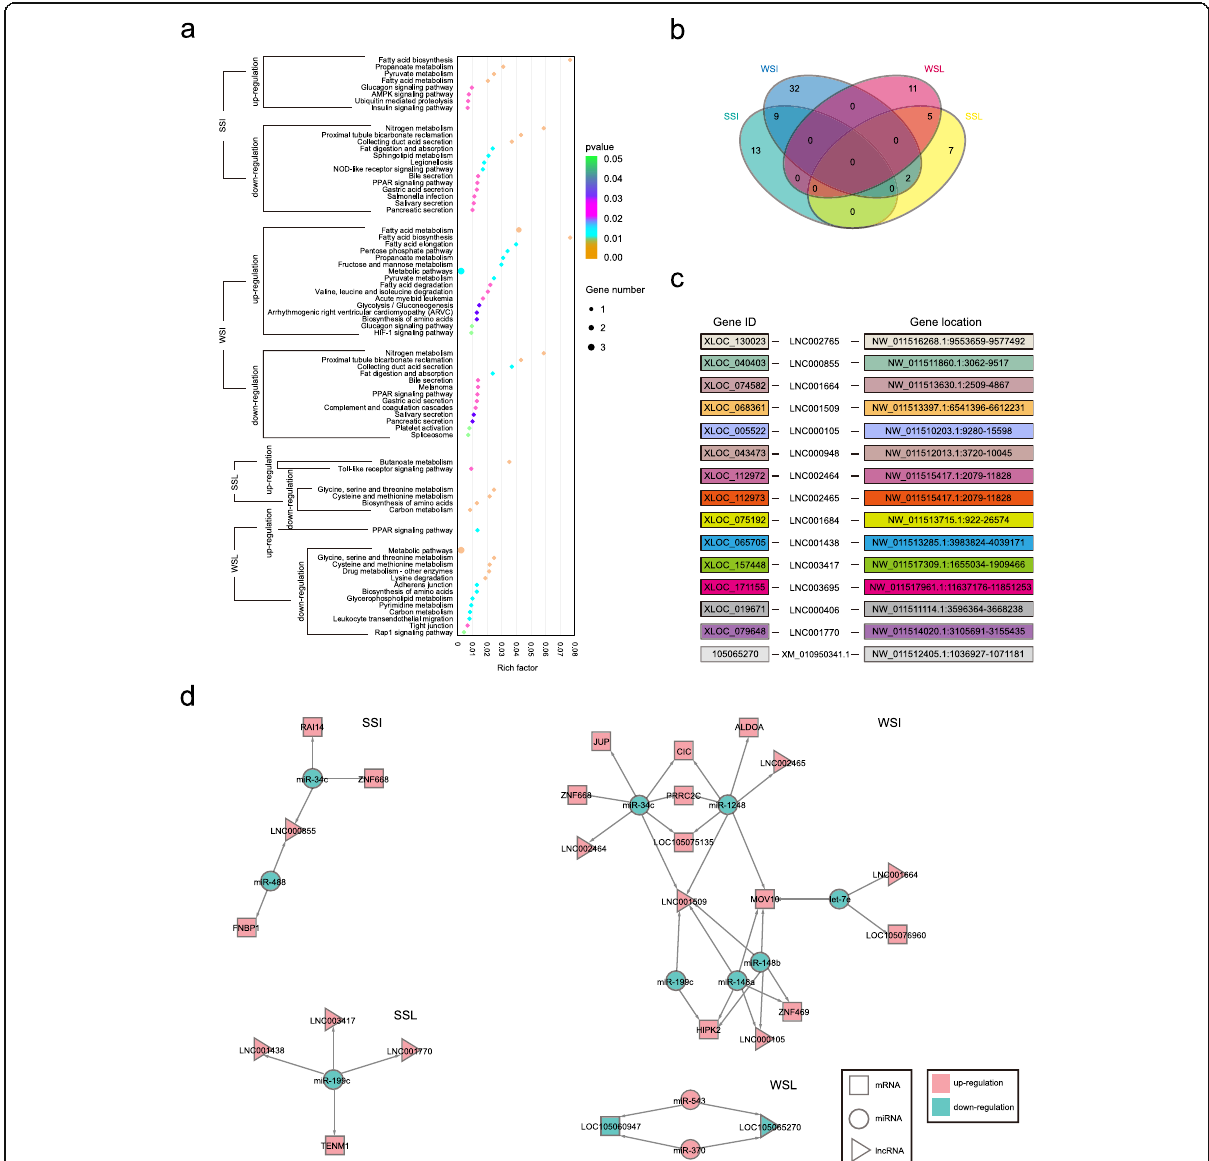
Fig. 4 Bioinformatics analysis for significantly differential ( P < 0.05) mRNAs, miRNAs and lncRNAs under stress. a KEGG pathway enrichment based on differential protein-coding genes. b Number of common protein-coding genes between stress groups. c Detailed genes information of differential lncRNAs. d Potential mRNAs, miRNAs and lncRNAs serving ceRNA theory. SSI, WSI, SSL and WSL separately indicate ileum under salt stress, ileum under water-deprivation stress, liver under salt stress and liver under water-deprivation